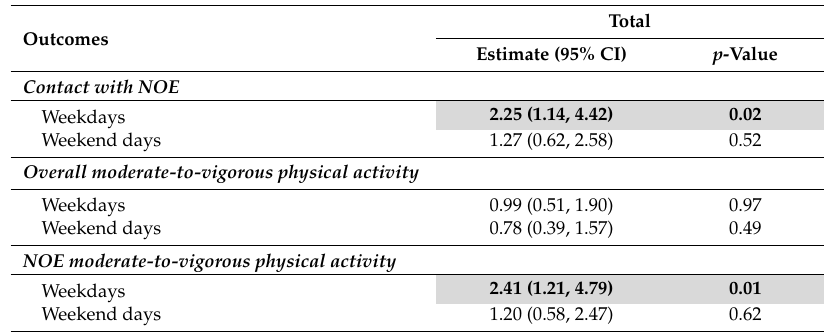
Table A8. Sensitivity models. Adjusted models for residential NOE availability defined as presence/ absence of green spaces at 500 m network